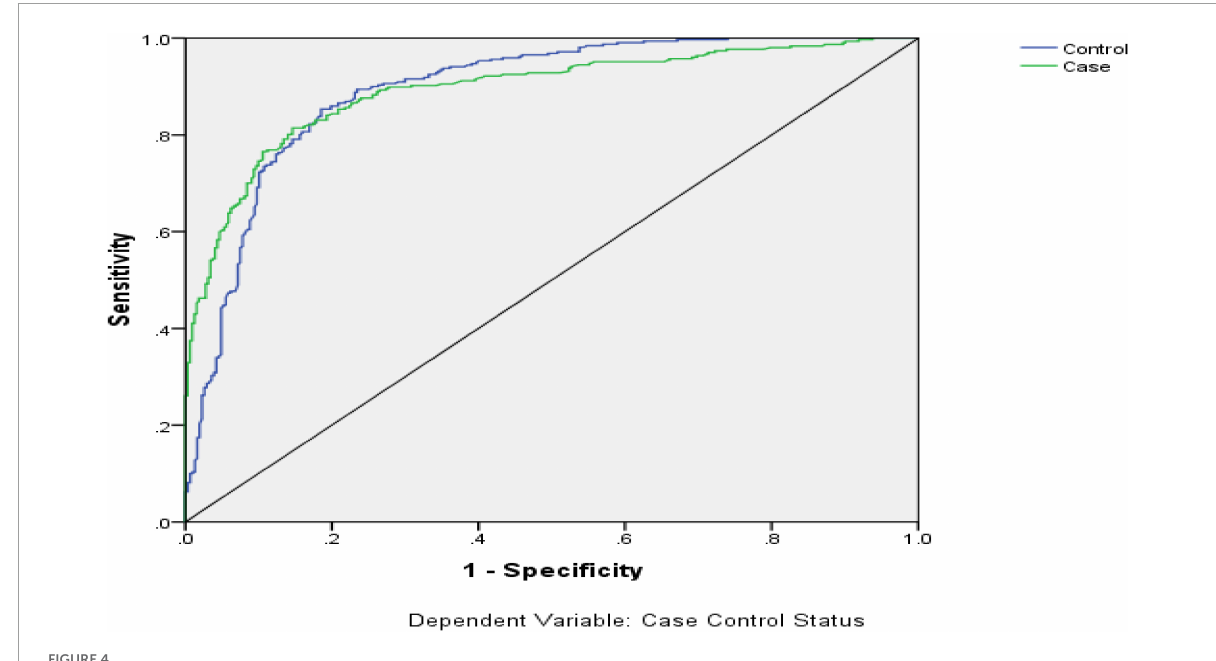
FIGURE4 The receiver operating characteristic (ROC) curve of multilayer perceptron prediction model.